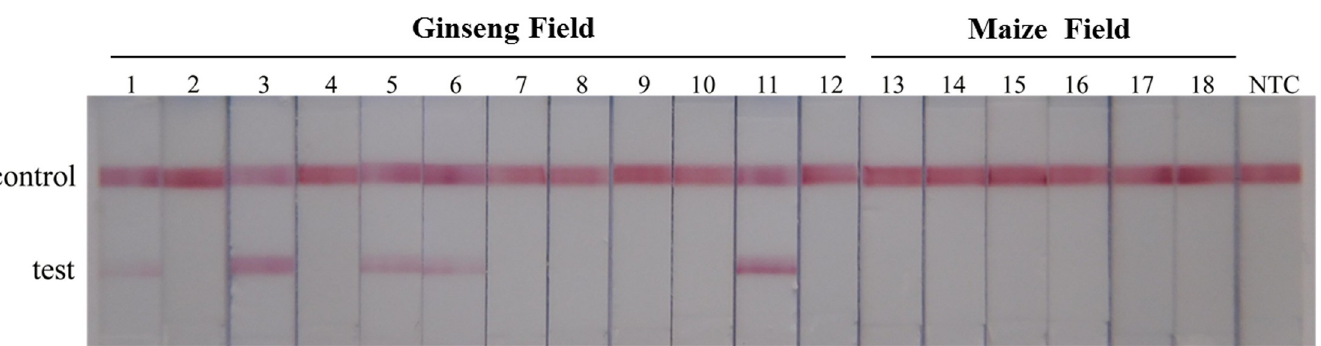
S1 Fig. The sequencing result of the PCR amplicon.